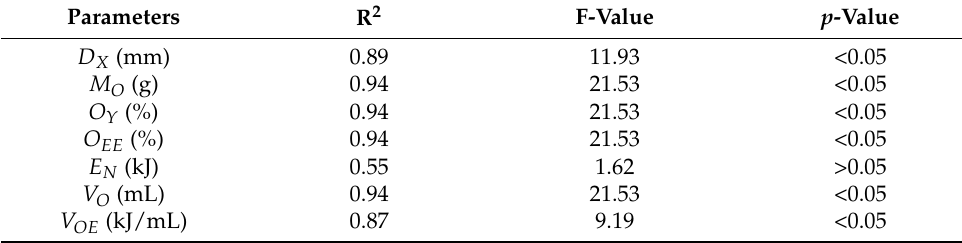
Table 2. ANOVA results of calculated parameters in relation to heating temperatures.